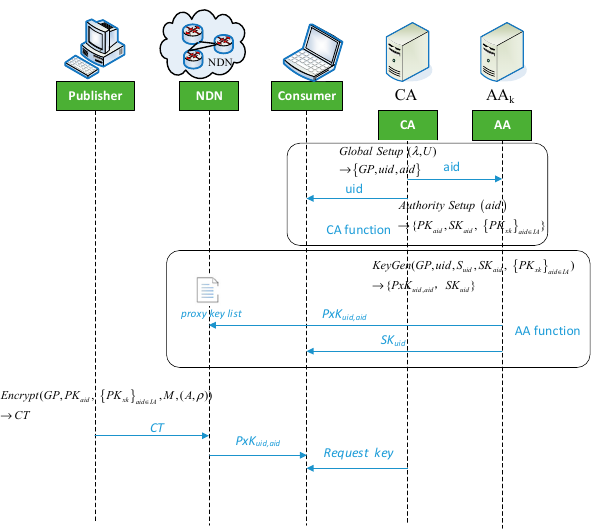
Figure 1. Flow of the Named Data Network (NDN) access control system.